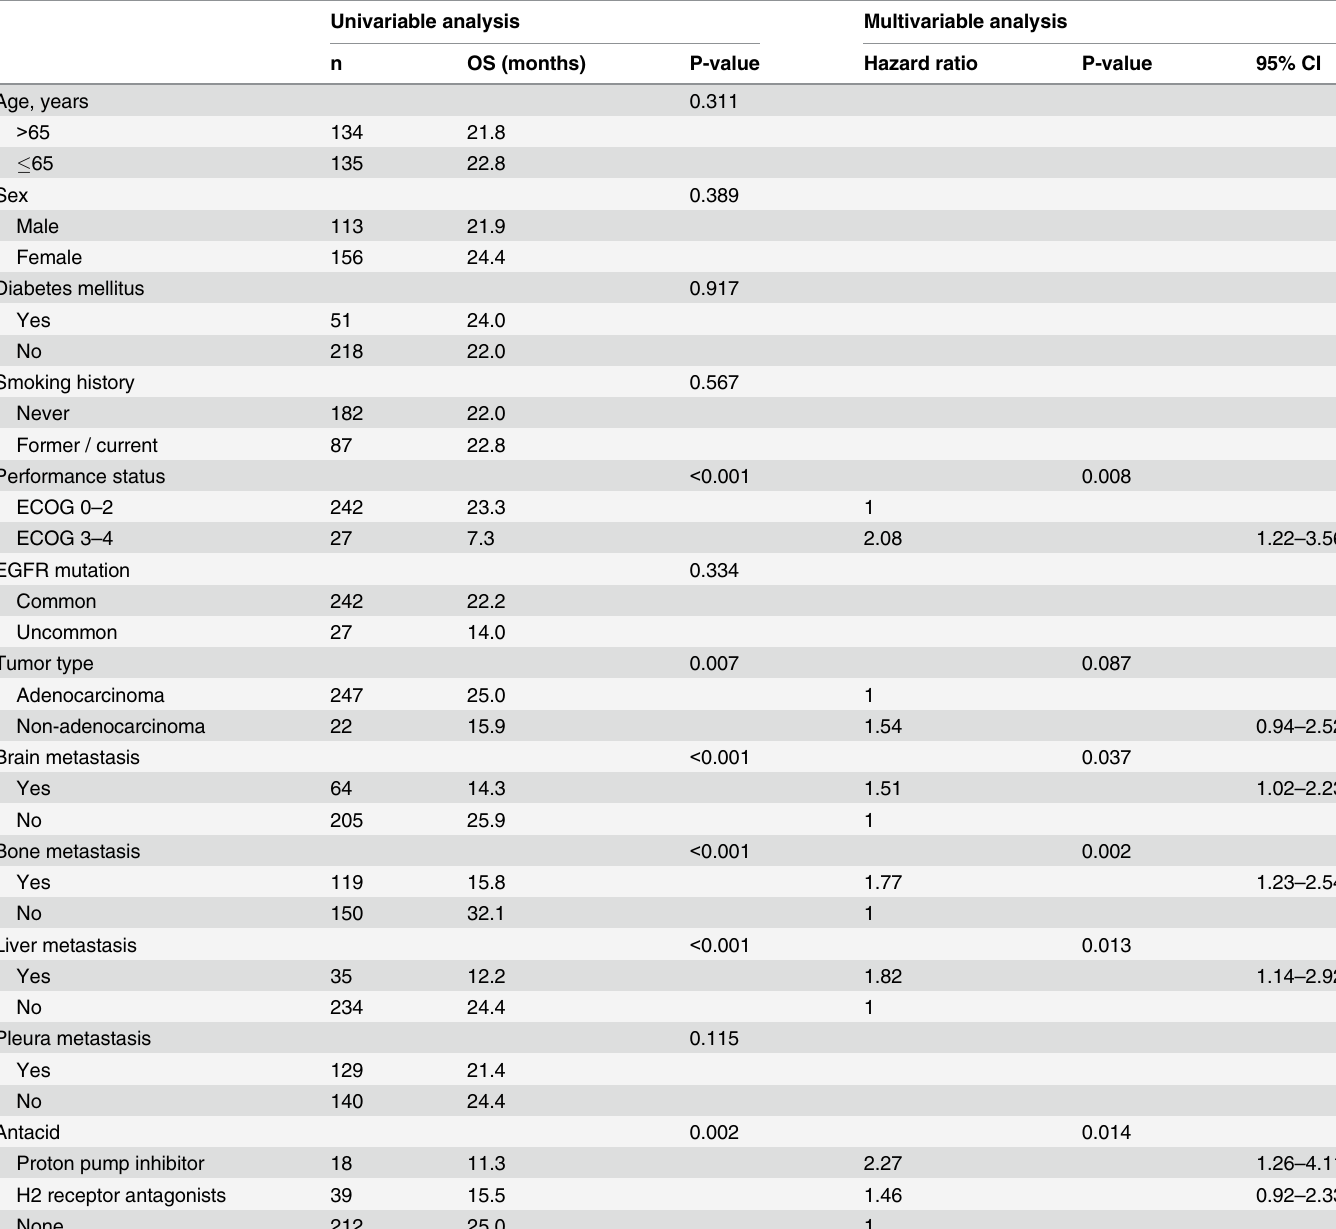
Table 3. Univariable and multivariable analysis of overall